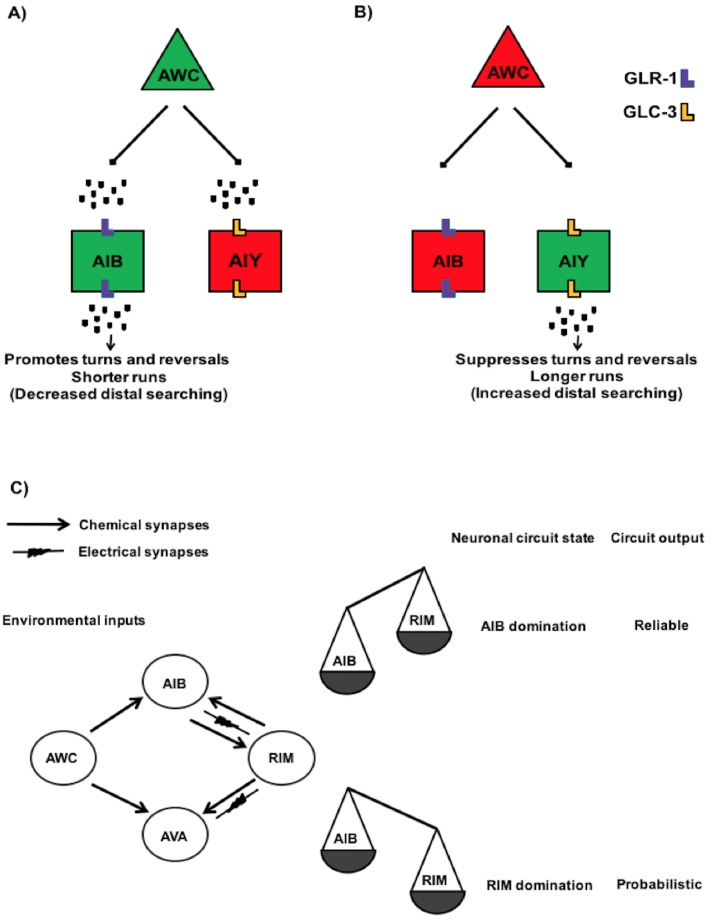
Neural circuits engaged in the regulation of locomotory behaviour in C. elegans.(A) Schematic showing the proposed circuitry that regulates locomotory behaviour upon food removal. Green and red colos show depolarized and hyperpolarized neurons, respectively. This circuitry consists of AWC sensory neurons and AIB and AIY interneurons. Food or odour removal results in AWC depolarization. Upon its depolarization, AWC releases glutamate at AWC/AIB and AWC/AIY synapses. The released glutamate then eventually acts on AMPA-type glutamate receptor GLR-1 in the AIB or glutamate-gated chloride channel GLC-3 in the AIY resulting in their depolarization and hyperpolarization, respectively. This neuronal pattern ultimately promotes reversals and turns resulting in shorter runs and increased local exploration (Chalasani et al., 2007). (B) Once AWC neuronal activity reduces, it however results in a reduction in the AIB neuronal activity and AIY depolarization that collectively leads to suppression of reversals and turns and inducing longer runs and distal exploration (Chalasani et al., 2007; Gordus et al., 2015). (C) Simplified wiring diagram showing the synaptic connection between AWC sensory neurons and three AIB, RIM and AVA interneurons in a circuit linking AWC to reversal behaviour. RIM, AIB and AVA participate in the overall network states. Once RIM is dominated, the circuit output is toward more probabilistic and upon domination of AIB the circuit output is more reliable (Model proposed by Gordus et al., 2015).